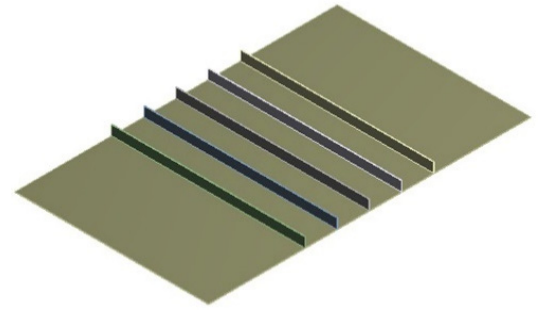
Figure 3. Illustration of the reinforcing ribs along the short side.